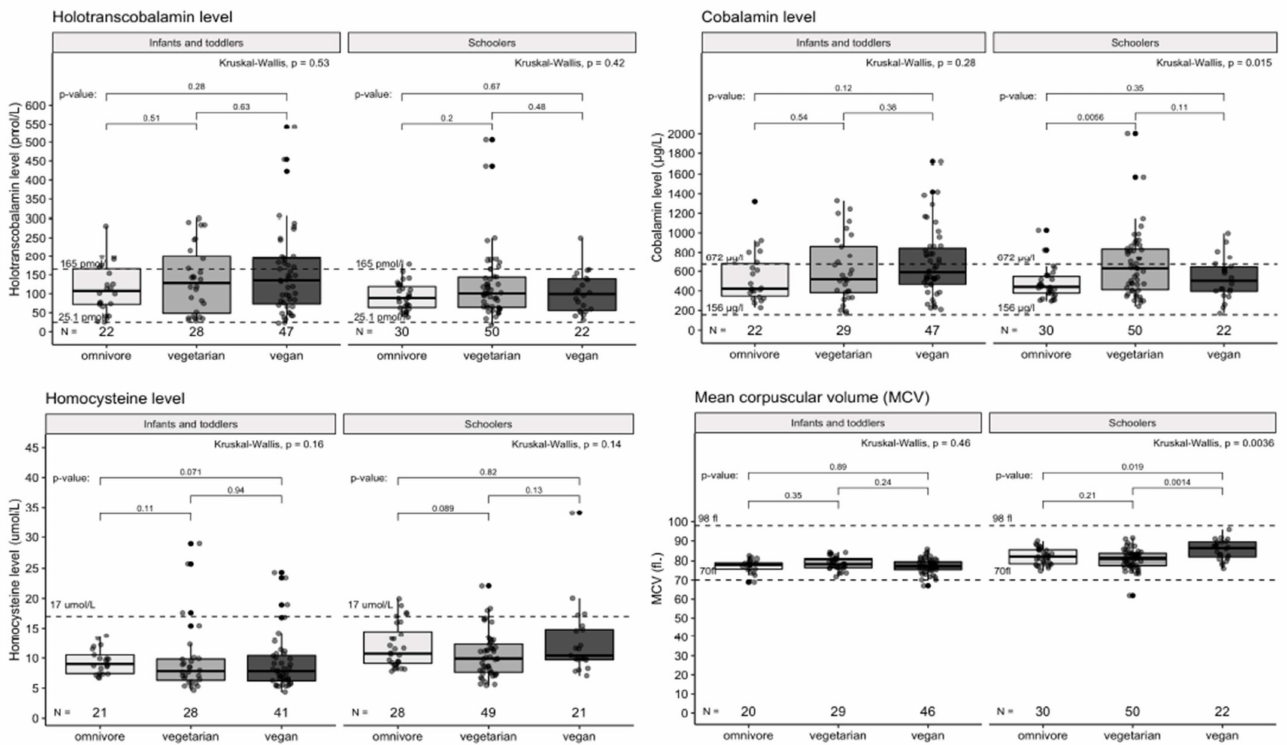
Figure 2. Laboratory markers of vitamin B12 metabolism in diet groups. Cross-sectional comparison of 69 VN, 79 VG and 52 OM. MCV (fl) = mean corpuscular volume. Dashed lines indicated the reference interval of the